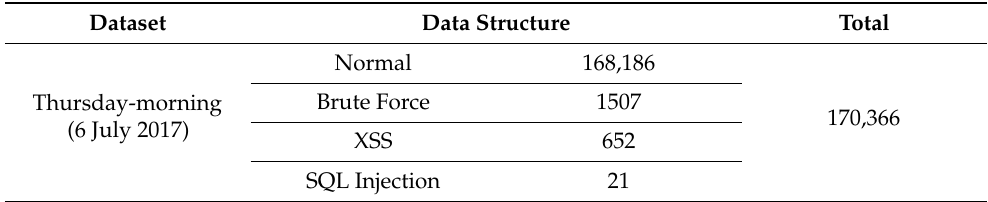
Table 3. Dataset